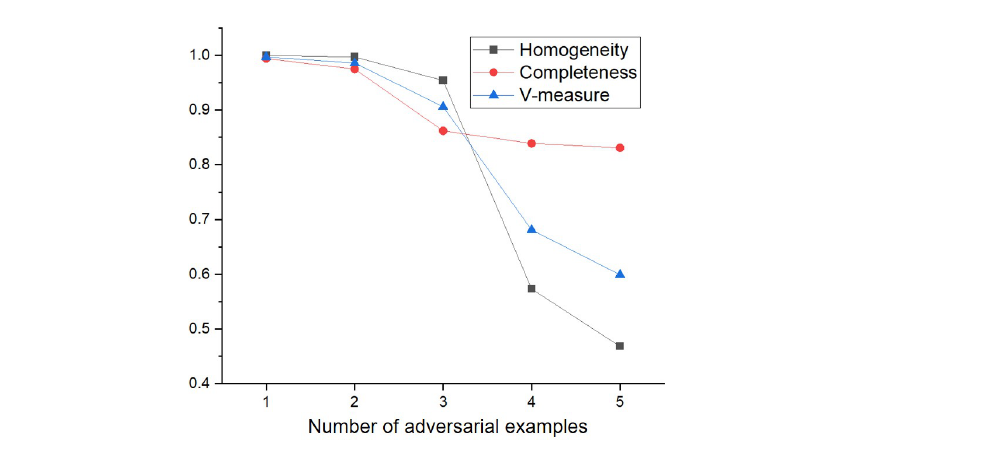
Figure 9. Clustering performance of proposed method with the increase of the number of adversarial examples using CIFAR-10